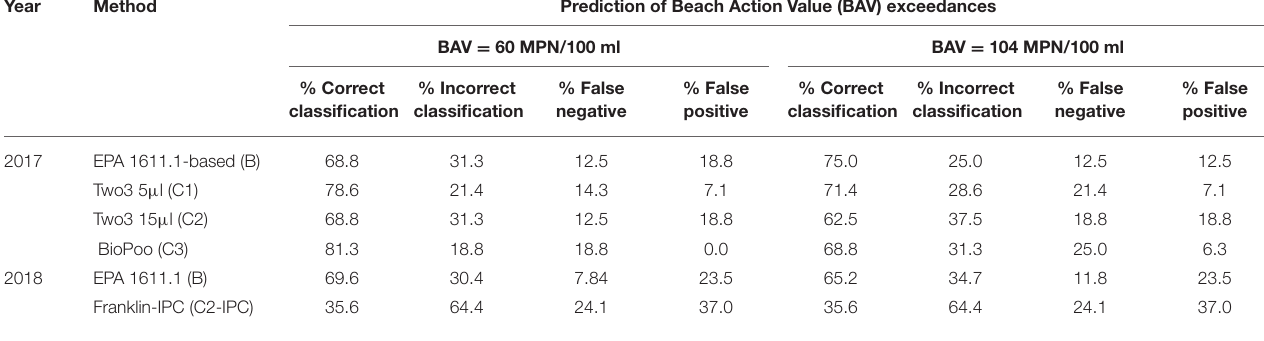
TABLE 2 | Accuracy of qPCR methods for predicting beach action value (BAV) exceedances as compared to the culture-based Enterolert method in fall 2017 and summer 2018 samples. Year